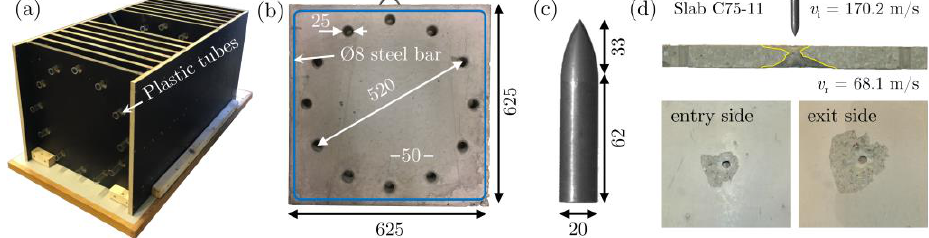
Fig. 2. Component test setup, (a) wooden moulds for casting, (b) geometry of concrete slabs, (c) geometry of ogive-nose projectile, and (d) typical perforation